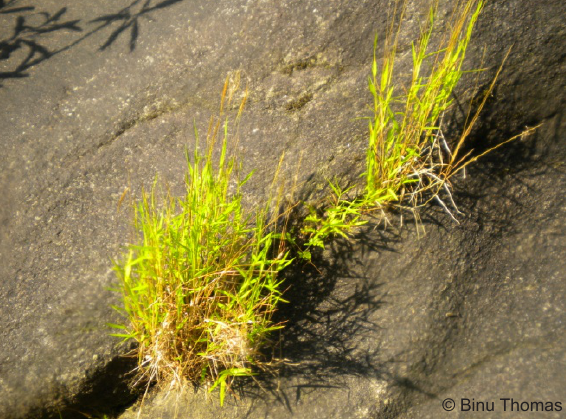
Image 2. Pogonatherum crinitum (Thunb.) Kunth.